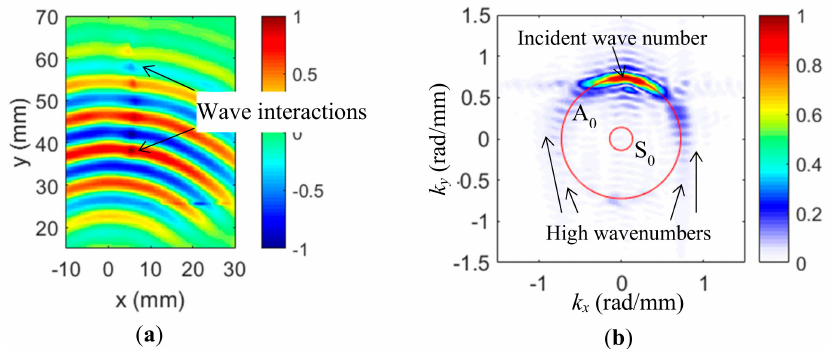
Figure 3. Experimental wavefield and wavenumber spectrum: ( a ) 2D wavefield at 35 µ s showing the wave interactions at the crack; ( b ) wavenumber spectrum at 120 kHz using the 3DFT method.